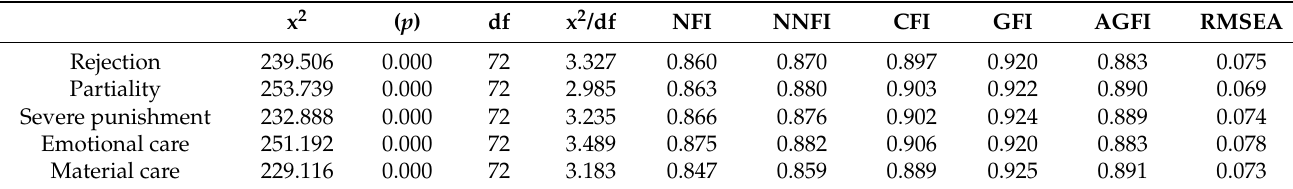
Table 2. Model fit indices.